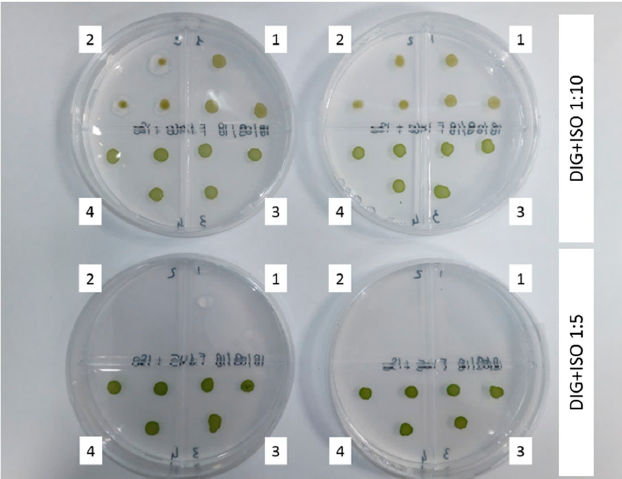
Figure 1. S. obliquus (1 and 2) and C. vulgaris (3 and 4) growth on Petri plate in DIG+ISO 1:5 and 1:10 test conditions.